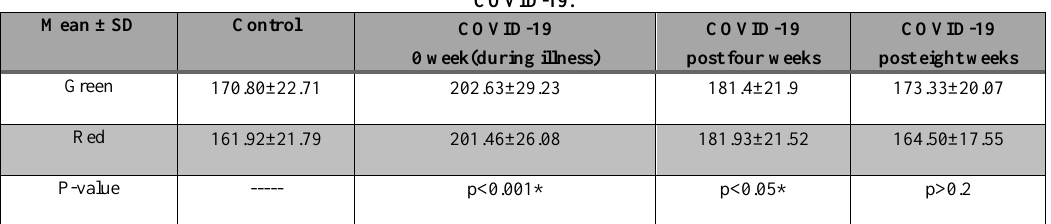
Table 2. Visual reaction time for green and red colour stimuli in the study versus control group during and after 4 and 8 weeks of recovery from COVID-19.